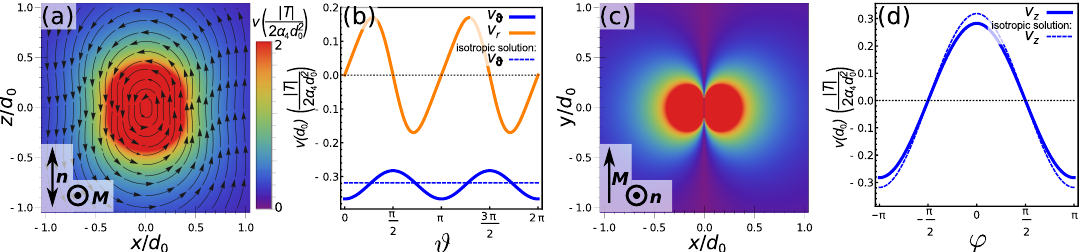
Figure 4. Flow field of a point torque in nematic. ( a , b ) flow field due to torque that is perpendicular to the director. Compared to the isotropic case ( b , see also Figure 1), the vortex stretches in the direction of the director; ( c , d ) same flow field in the xy cross-section. In ( c ), flow lines point in (out) of the